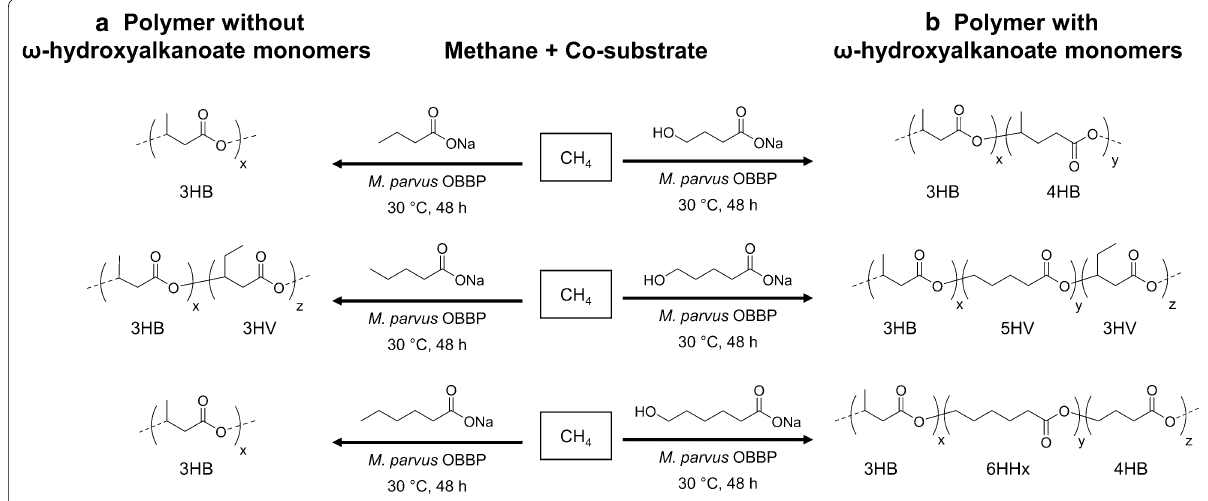
Fig. 5 Scheme of PHA production using methane and co-substrates. a Without the hydroxyl group and b with the hydroxyl